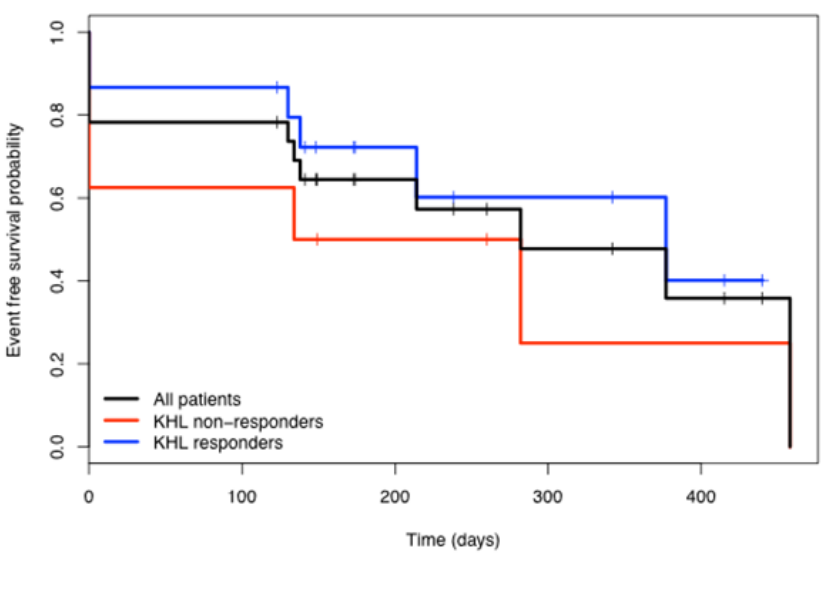
Figure 5. Kaplan-Meier analysis comparing the number of disease-free days of all patients with those that did or did not develop anti-KLH antibodies.